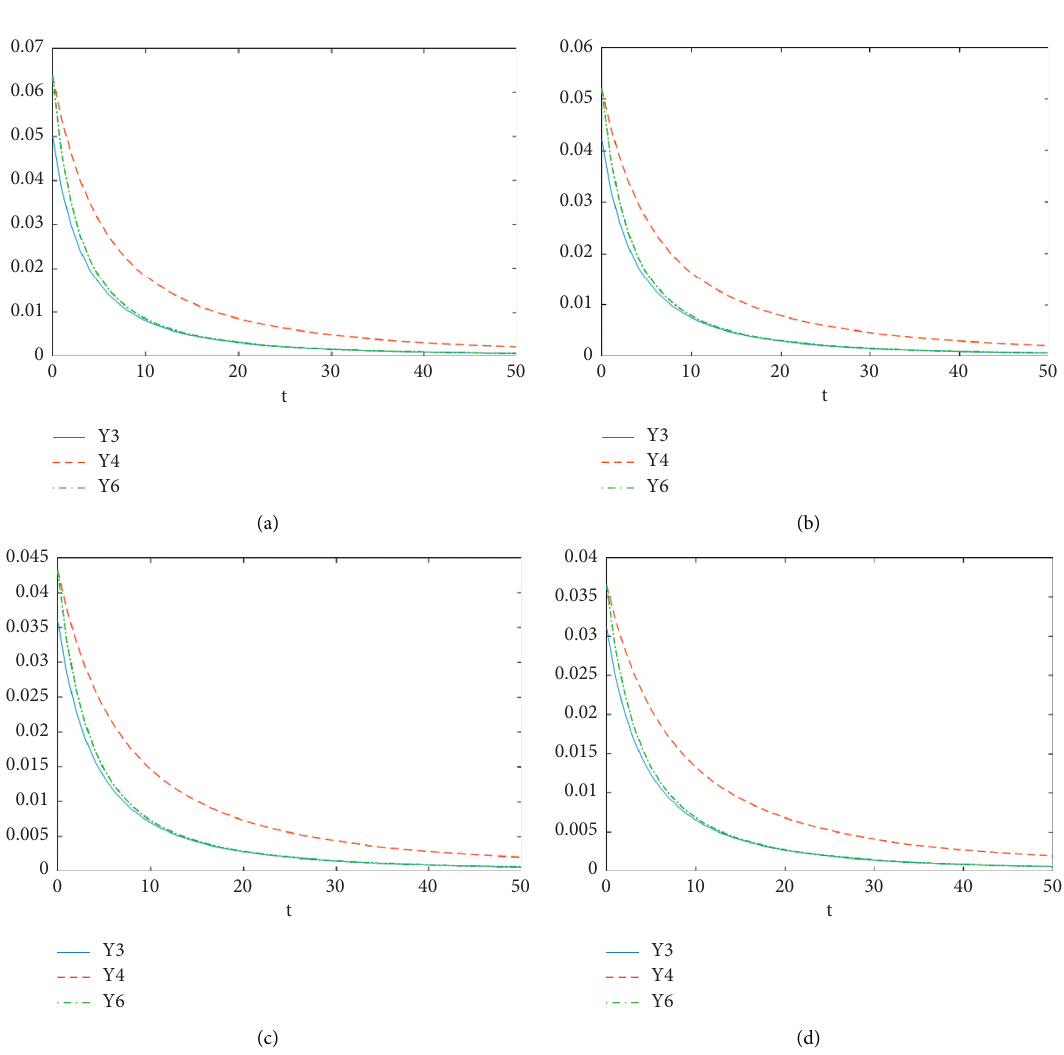
� 6 . 5, s � 5 . 8). (a) β � 0 . 2. (b) A B